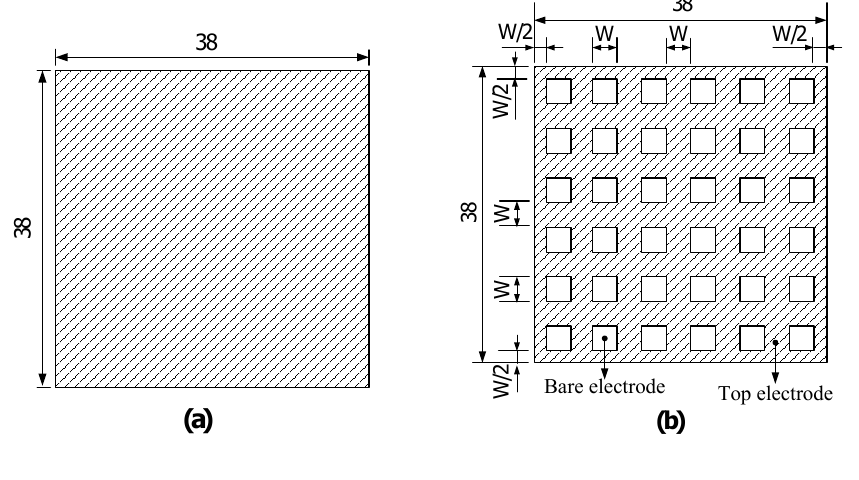
Figure 1. Top electrode dimensions in mm: ( a ) fully covered type; ( b ) mesh